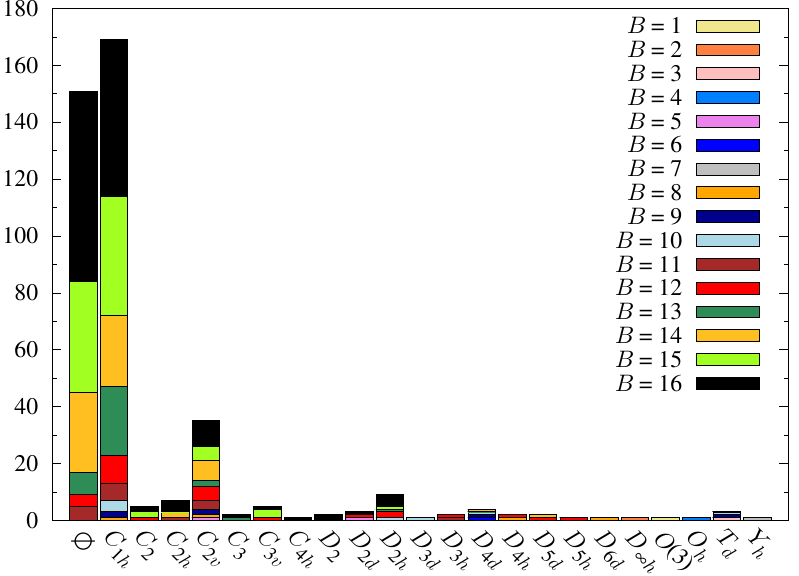
Figure 14. Number of solutions possessing certain